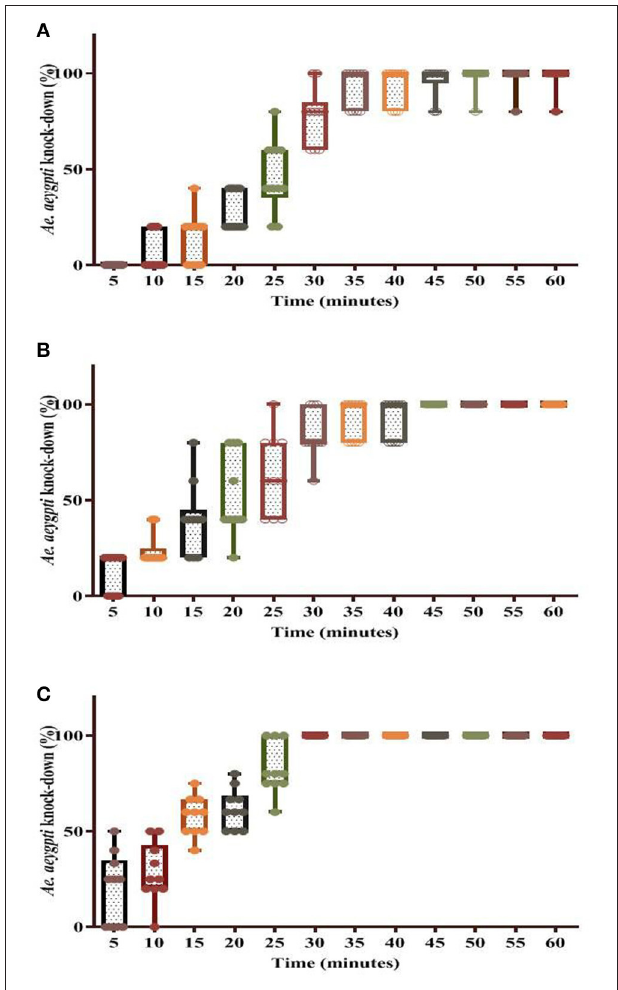
FIGURE 5 | Knockdown rate of dengue vector Ae. aegypti using different formulations at time T0. (A) WSRIP-1; (B) WSRIP-2; (C)